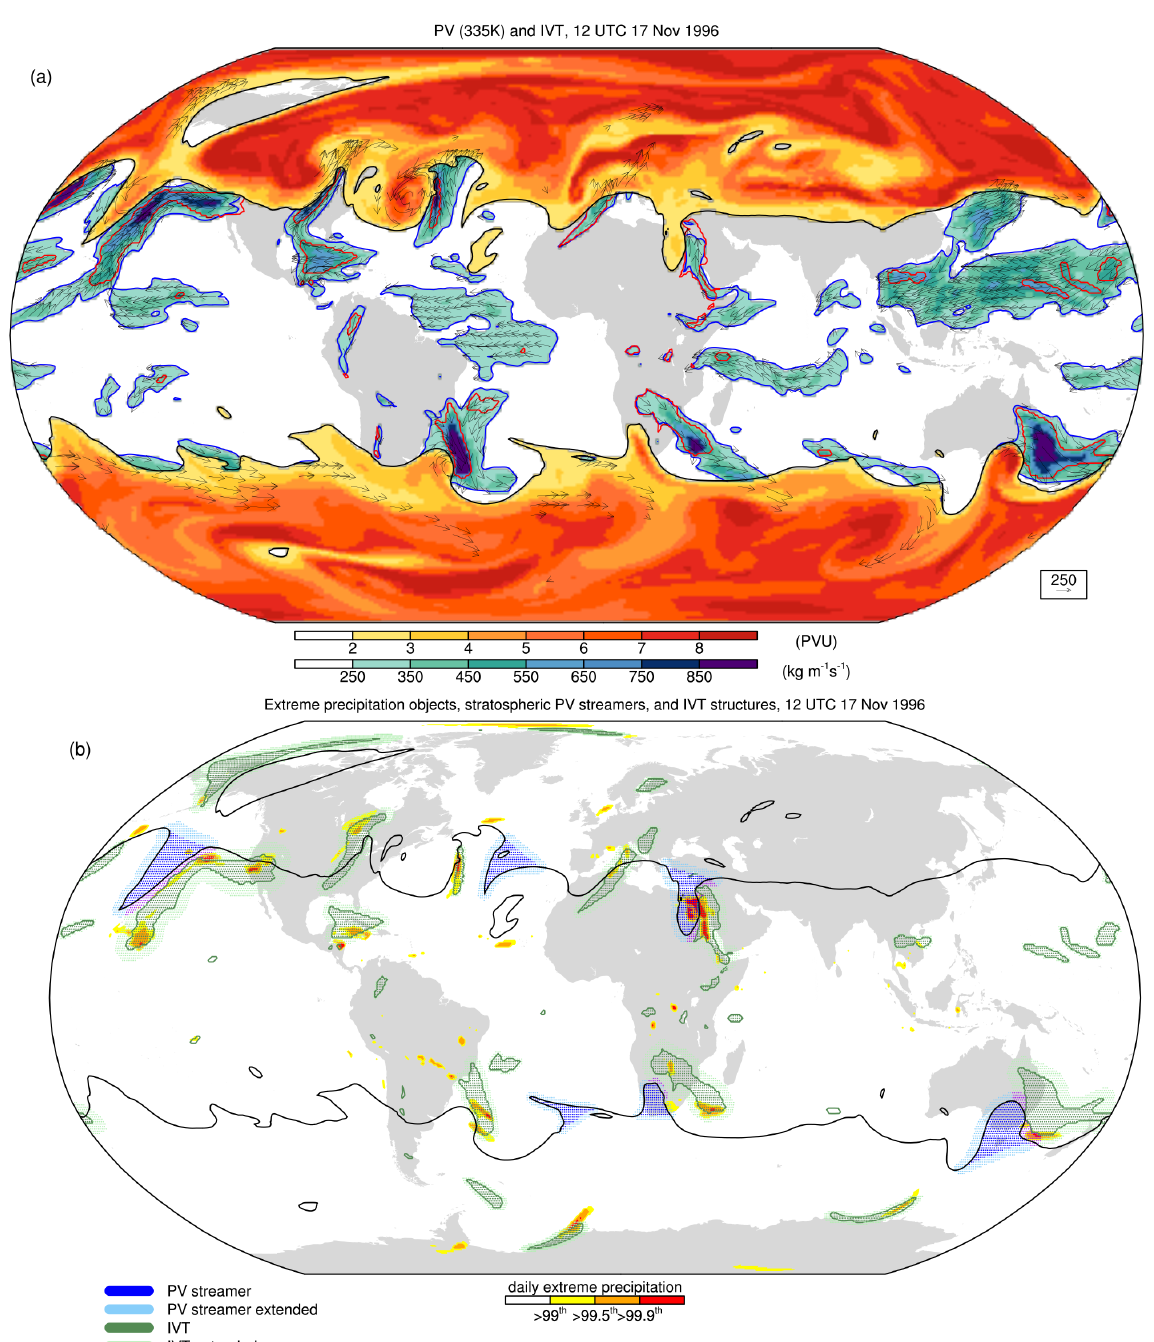
Figure 3. Example of the algorithm (a) input and (b) output for stratospheric PV streamers and IVT pct structures at 12:00UTC on 17 Novem- ber 1996. In (a) PV (PVU) in absolute values on 335K in yellow/red colours, full IVT (kgm − 1 s − 1 ) in green/blue colours, and IVT vectors in black, only plotted where the full IVT magnitude > 250kgm − 1 s − 1 . Contour lines denote the ± 2PVU contours (black), the 250kgm − 1 s − 1 full IVT (blue), and the annual 95th IVT percentile with a lower threshold of 200kgm − 1 s − 1 (red). In (b) the identified stratospheric PV streamers, IVT structures in the IVT pct form, and their areas of influence, as indicated by the colours in the legend. Also, (b) shows the 99th, 99.5th, and 99.9th percentile exceedances of daily ERA-Interim